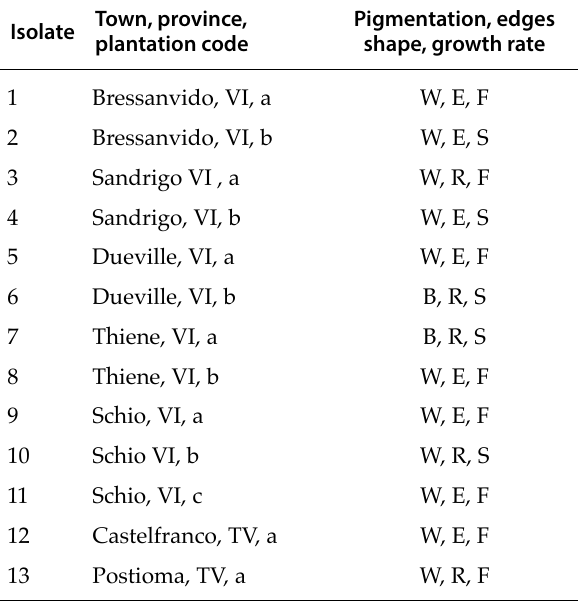
Table 1. Isolate code, site and macroscopic features for the 13 Geosmithia morbida isolates. Province: VI = Vicenza, TV = Treviso. Pigmentation: W = whitish-orange, and B = or - ange-brown. Edge shape: E = mainly even and R = mainly rough. Growth rate: F = fast and S = slow. Geographic loca - tions of the isolates are reported in Figure 2.